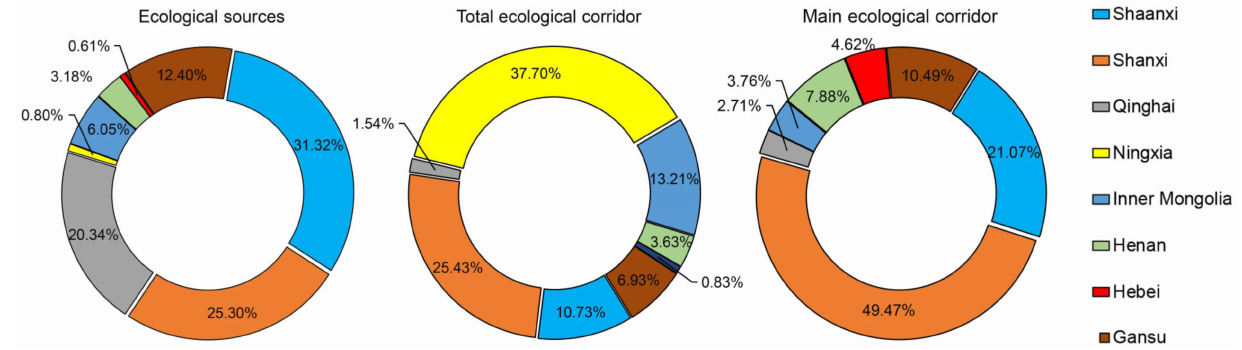
Figure 7. Ecological sources and corridors in each administrative area of